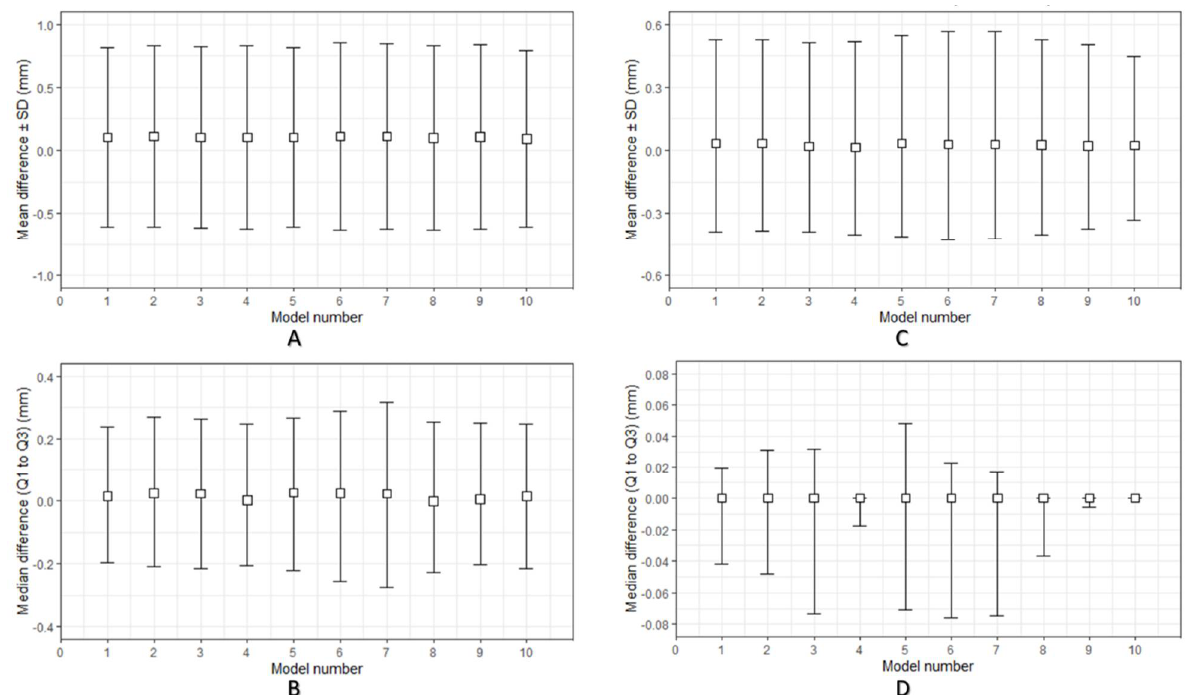
Figure 1. Descriptive data distribution illustrating the geometric characteristics of the material extrusion 3D-printed PEEK cranial patient-specific implants (specimen model 1-10): ( A ) Dimensional accuracy mean difference ± standard deviation (SD) (mm) between planned and 3D-printed PEEK cranial implants; ( B ) Dimensional accuracy median difference (Q1 to Q3) (mm) between planned and 3D-printed PEEK cranial implants; ( C ) Dimensional repeatability mean difference ± standard deviation (SD) (mm) among 3D-printed PEEK cranial implants; ( D ) Dimensional repeatability median difference (Q1 to Q3) (mm) among 3D-printed PEEK cranial implants.